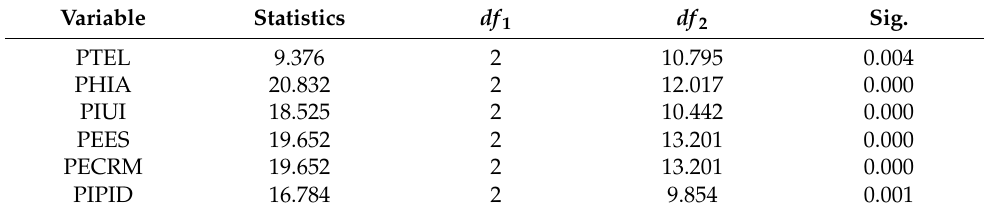
Figure 2. Cluster generation dendrogram corresponding to 2021. Table 8. Welch’s robust test of equality of means for 2021